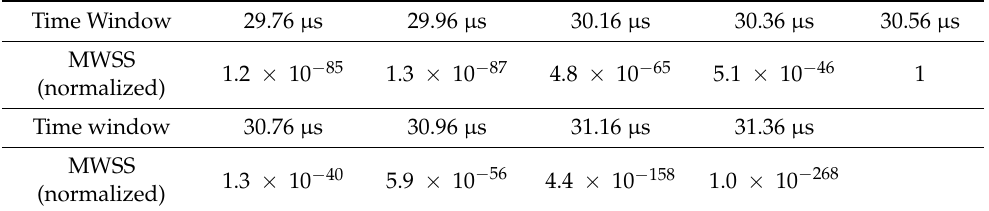
Table 1. Normalized MWSSs for the time windows shown in Figure 5.